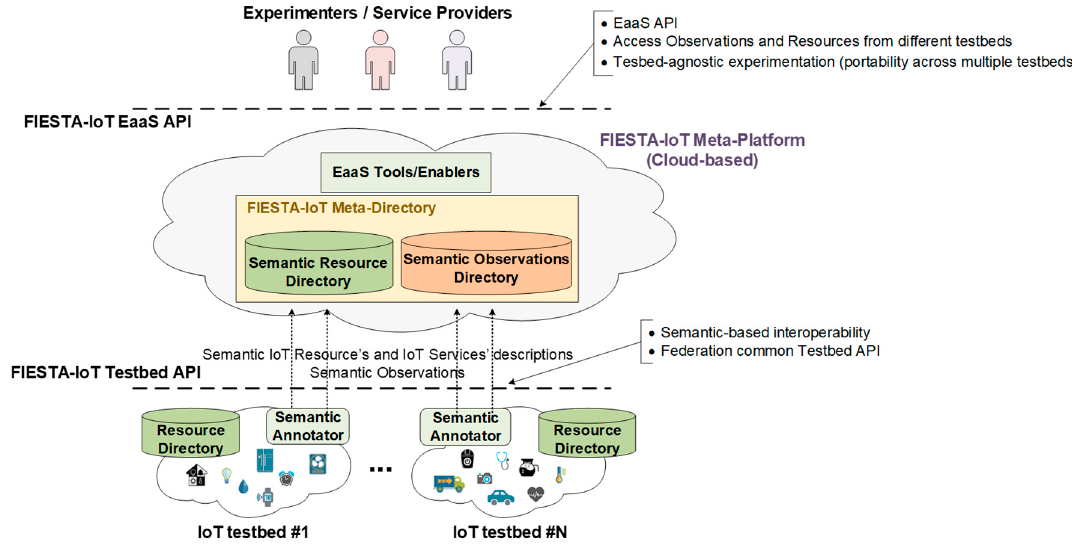
Figure 1. FIESTA-IoT Platform abstract EaaS and testbed federation concepts overview.